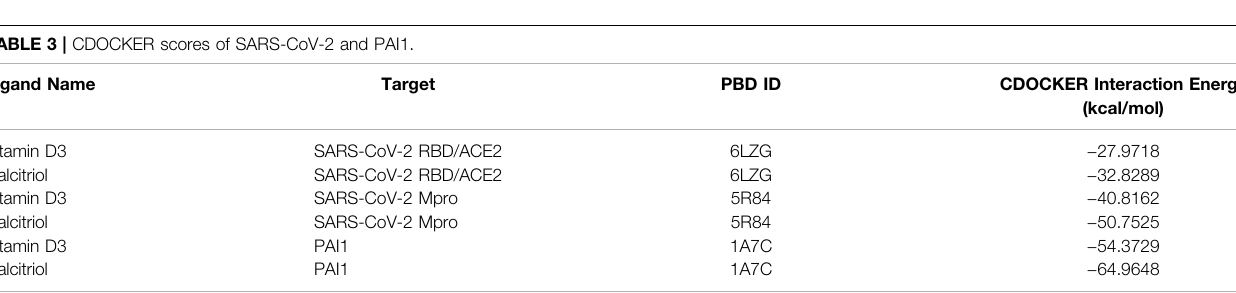
TABLE 3 | CDOCKER scores of SARS-CoV-2 and